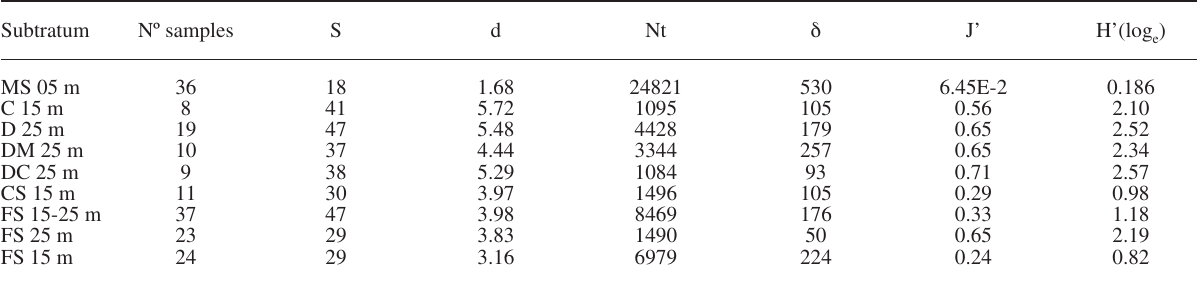
Table 6. – Values of Specific richness (S), Margafef’s richness (d), total abundances (Nt), density or number of specimens by 100 m 2 ( d ), Pielou’s equitability (J’), Shannon’s diversity (H’) for the different assemblages by sediments (MS: shallow medium and fine sandy bottoms of 5m; FS: fine sandy bottoms with mud (at 15 and 25 m); CS: coarse bottoms at 15 m; C: coralligenous bottoms; D: detritic bottoms at 25 m (of medium sands: DM, and of coarse sands: DC). Subtratum Nº